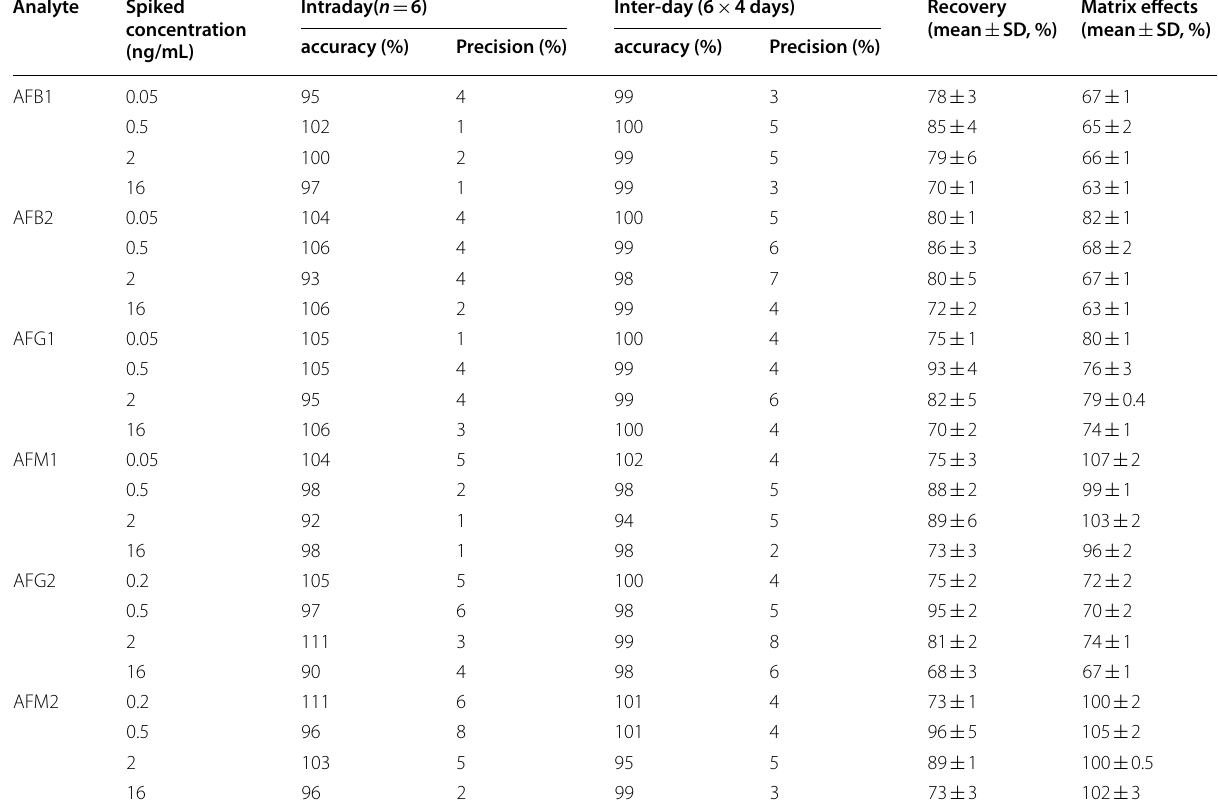
Table 3 Precision, accuracy, recovery, and matrix effects of aflatoxins in